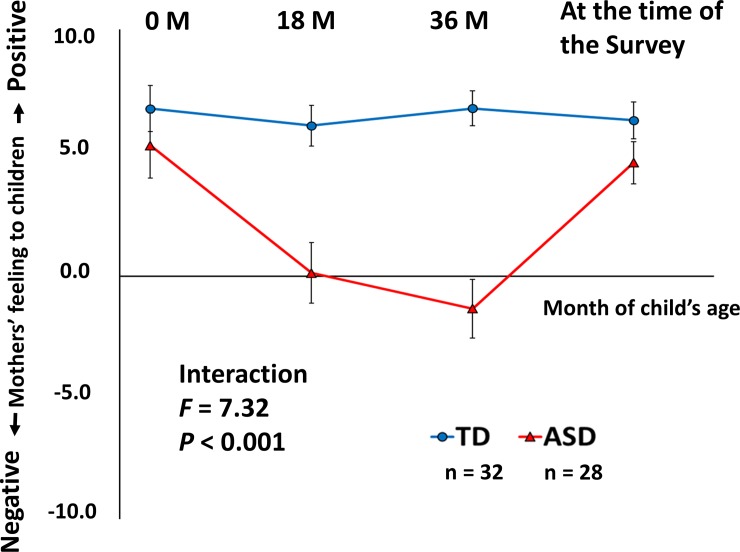
VAS scores of mothers’ feelings for their children.Red triangles indicate parents who have ASD children (n = 28). Blue circles indicate parents who have TD children (n = 32). A two-way ANOVA revealed a significant interaction between diagnosis and time. The values indicate the mean. Error bars represent the standard errors.